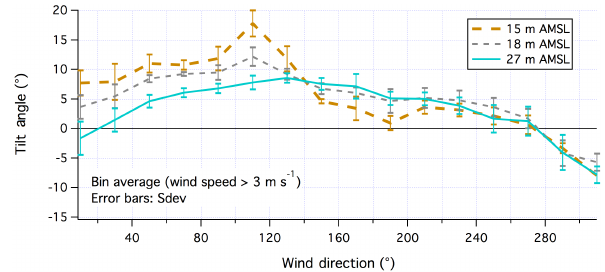
Figure 2. Tilt angle vs. true wind direction at three sampling heights. Lines represent averages (wind speed > 3ms − 1 only) and the error bars indicate standard deviations within each wind direc- tion bin. Wind data are from the Windmaster Pro sonic anemometer.